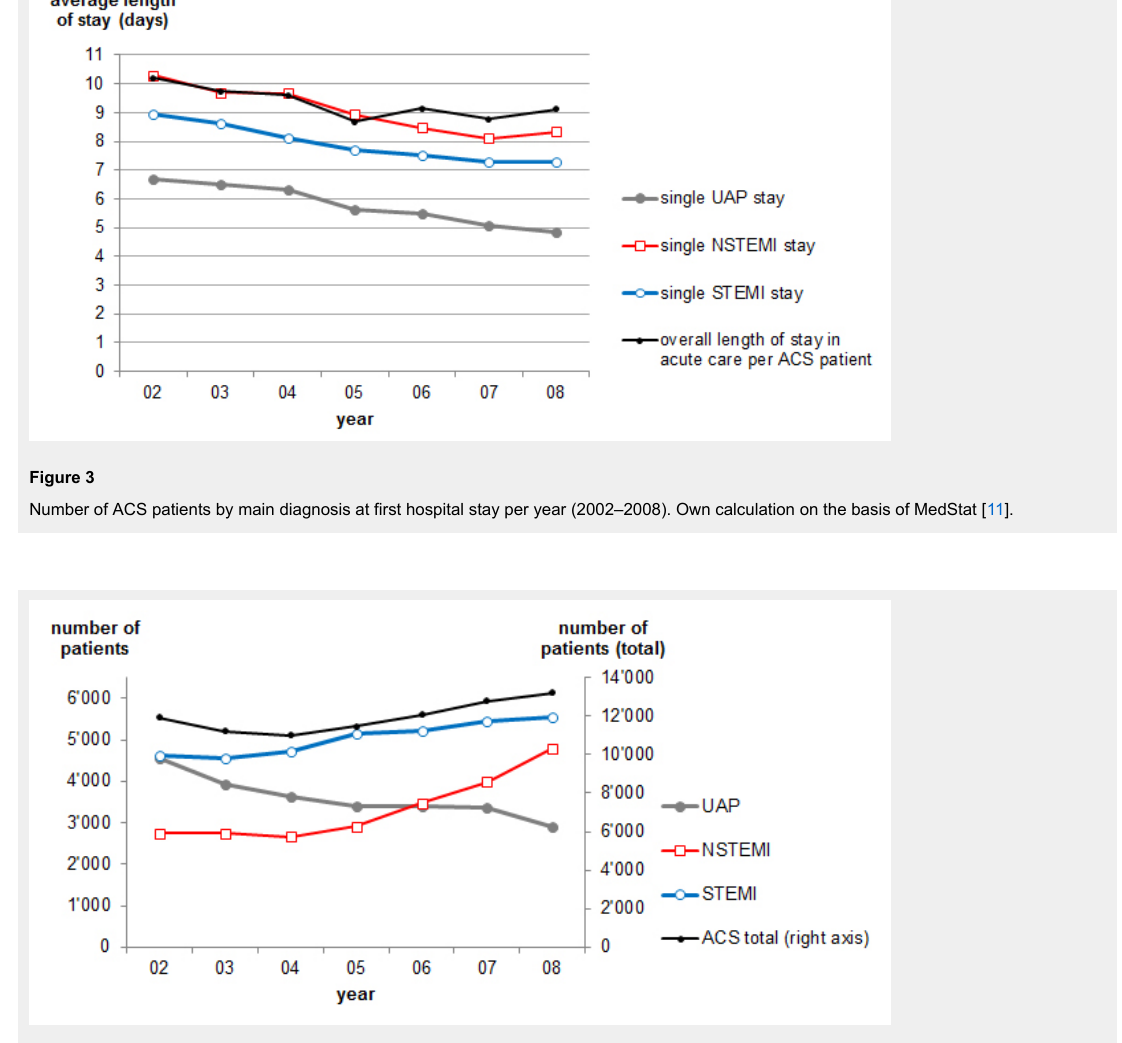
Figure 4 Average length of stay in acute care by single stay and by patient (2002–2008). Own calculation on the basis of MedStat [11]. Average length of stay per patient is higher than average length of single stays as many patients have multiple stays in the course of their ACS treatment (e.g. when a patient is transferred from one hospital to another for specialised